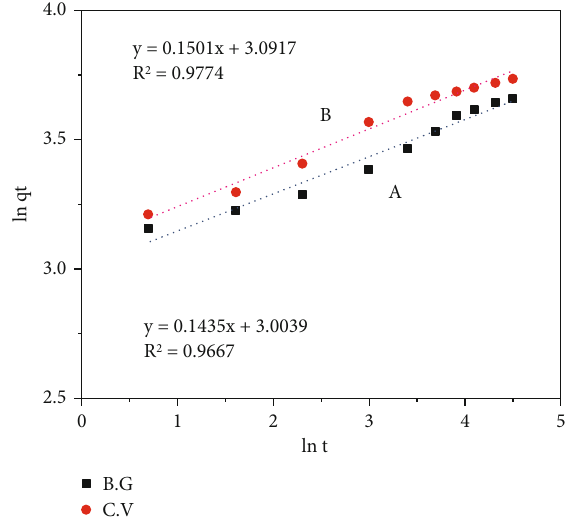
Figure 13: Fractional power model designs of B.G. and C.V. dyes from aqueous solutions to the binary P3NT/30%AgTiO Experimental conditions are illustrated in the batch extraction